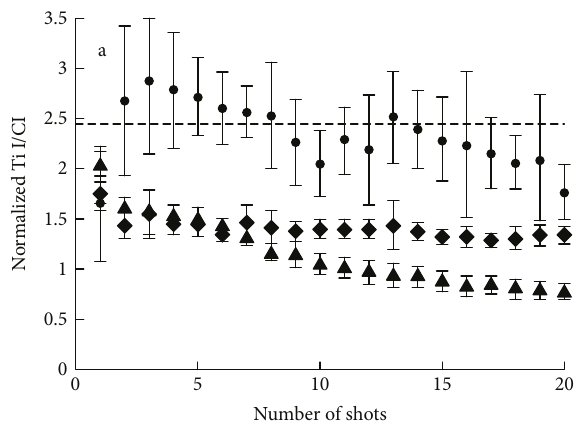
Figure 8: Evolution of the normalized Ti I 398.18 nm/C I 247.86nm intensity ratio of the thermally debound sample. The dashed line shows the sintering threshold. The di ff erent energies used were 200mJ ( ● ), 100mJ ( ♦ ), and 50 mJ ( ▲ ) per pulse.